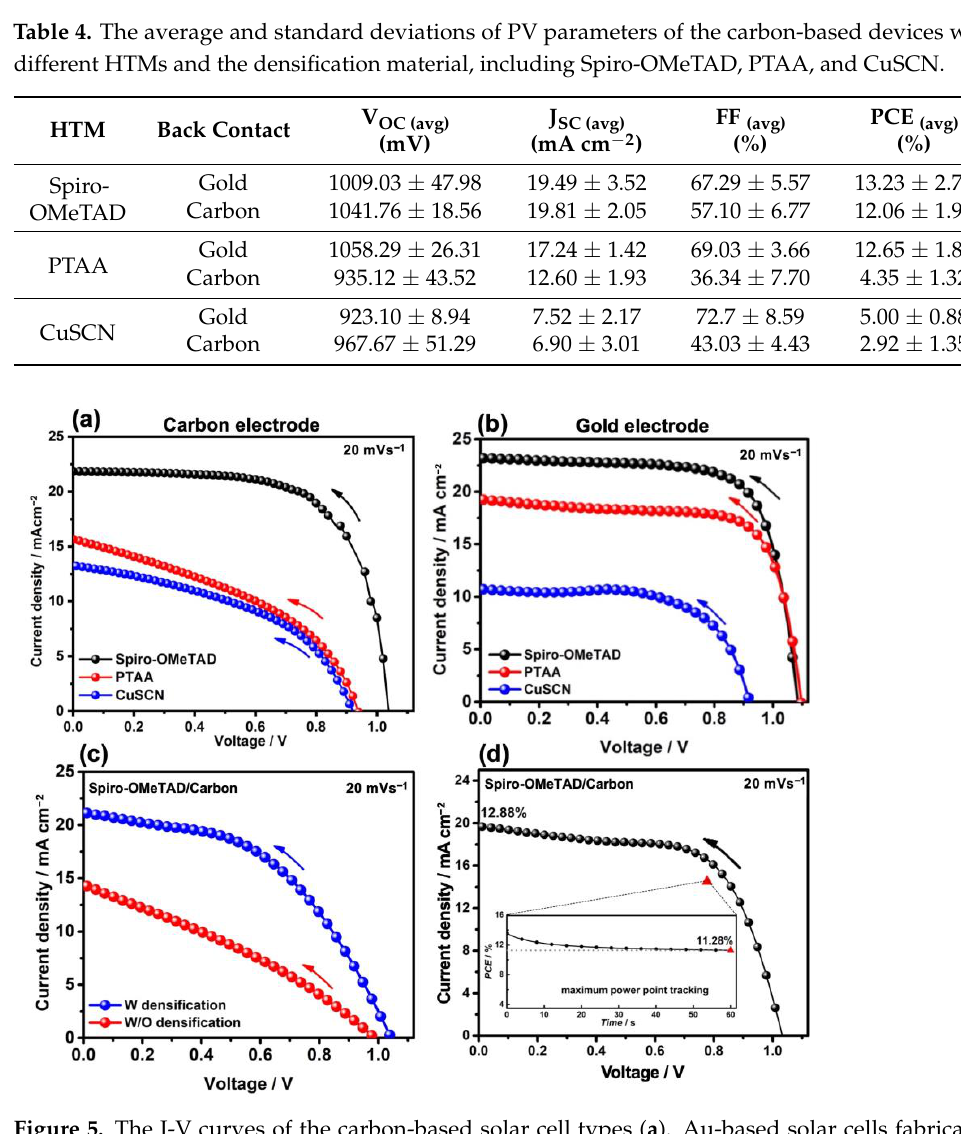
Figure 5. The J-V curves of the carbon-based solar cell types ( a ). Au-based solar cells fabricated by different HTLs ( b ). Spiro OMeTAD/carbon or gold cell in black, PTAA/carbon or gold in red, and CuSCN/carbon or gold device in blue. The arrows indicate the backward J-V scan direction at 20 mV s −1 . The J-V curves of the different carbon-based solar cell types (c); Spiro-OMeTAD/carbon com- position/Spiro-OMeTAD cell (with densification) in blue and Spiro-OMeTAD/carbon composition device (without densification) in red. Backward J-V curve and MPP tracking of the carbon-based solar cells ( d ). The voltage scan rate for all of the scans was 20 mV s −1 . The proper densification of the carbon fibers into the carbon paste can be obtained by dropping a small amount (3 μL) of HTM on top of the back contact. The densification process increased all PV parameters in carbon-based devices, as shown in Figure 5c and Table 5. The record PCE for the carbon-based devices increased from 4.4 to 10.6% by ap- plying a densification HTM (Spiro-OMeTAD) to the back contact. Moreover, the carbon- based devices showed a low hysteresis, as can be seen from Figure 5d and Table 6, and the maximum power point tracking (MPP) PCE value (11.28%) was on par with the one obtained from backward J-V scan direction (12.88%).